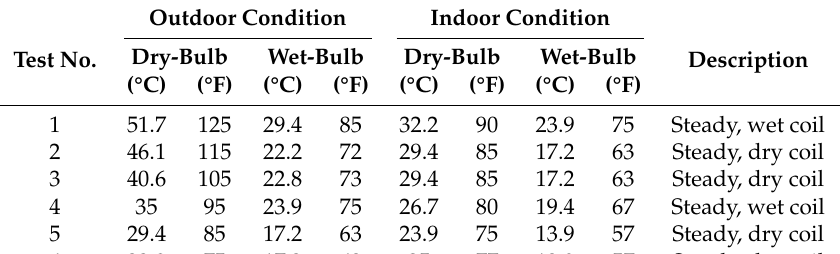
Table 2. Experimental testing conditions in psychrometric rooms.